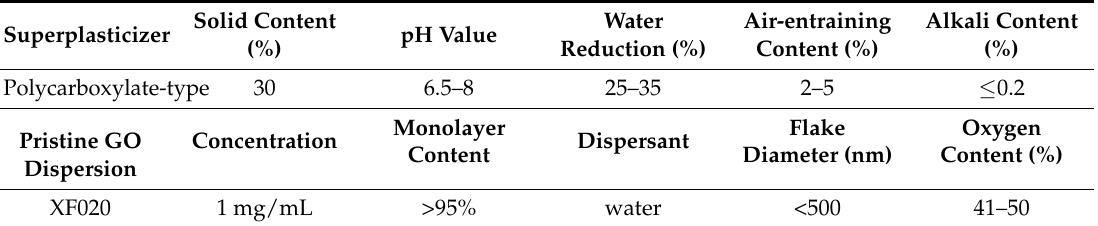
Table 4. Physico-chemical properties of superplasticizer and pristine graphene oxide (GO) dispersion. Solid Content Superplasticizer (%)